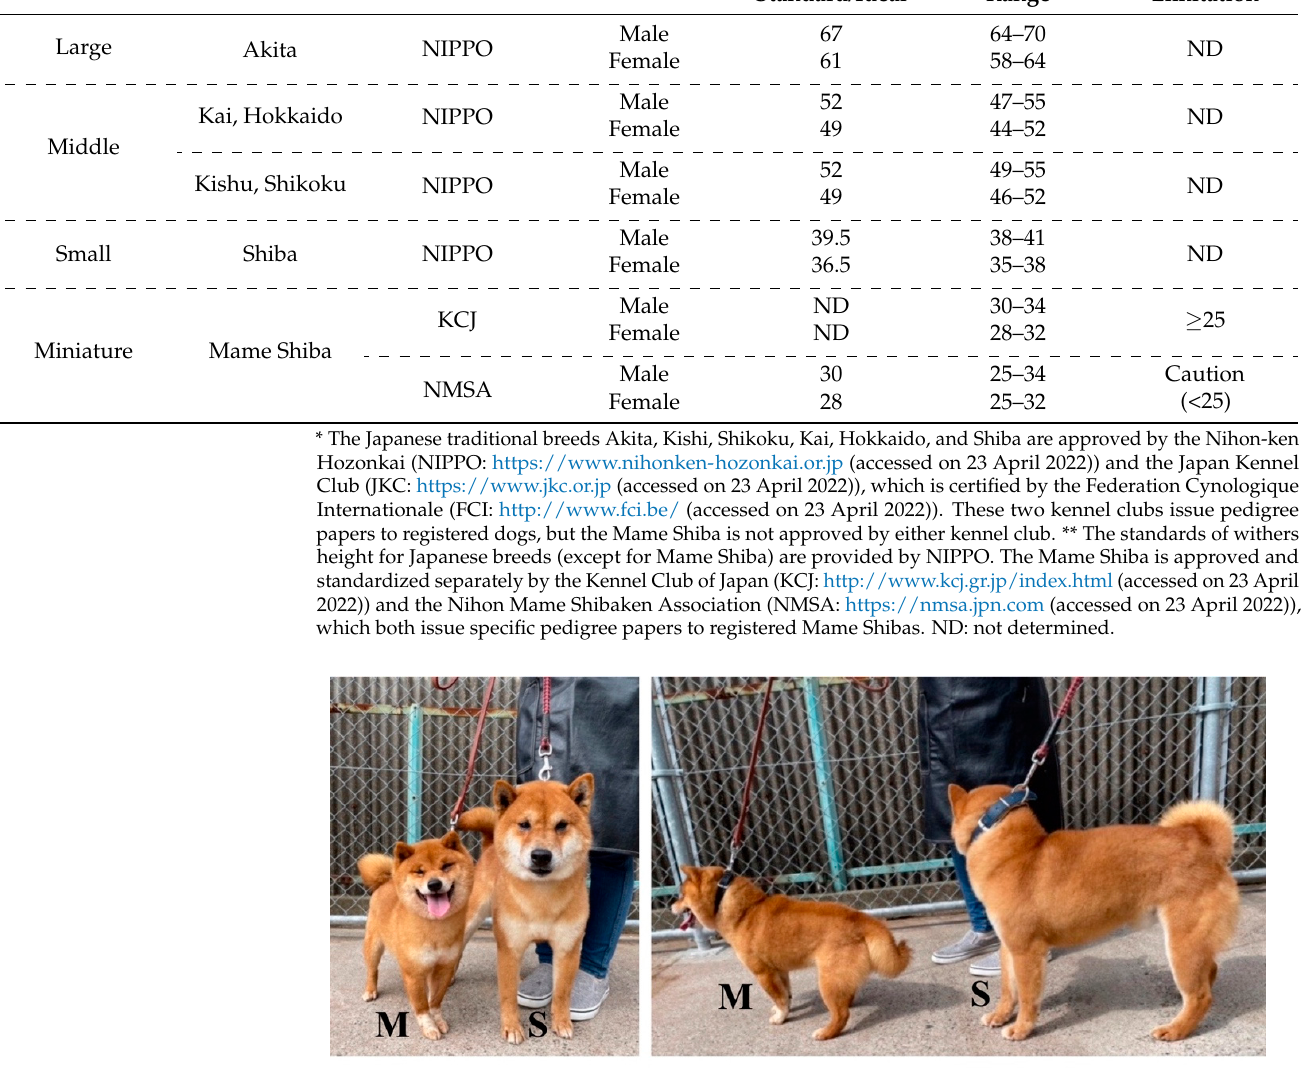
Figure 1. Typical appearance of a Shiba Inu (S: standard type) and a Mame Shiba Inu (M: miniature type). The coat color of these dogs is red, the most popular among the four coats found in these breeds (red, black ‐ and ‐ tan, sesame, and white).